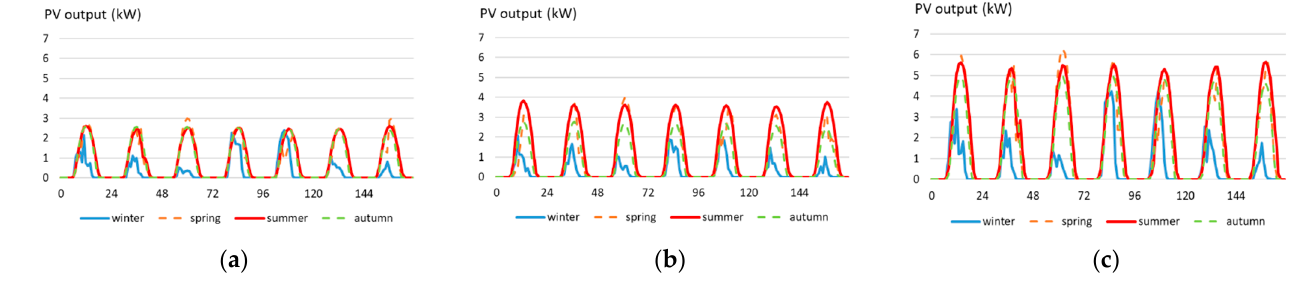
Figure 5. Seasonal PV contribution of: ( a ) 3 kW; ( b ) 5 kW; and ( c ) 7 kW systems.